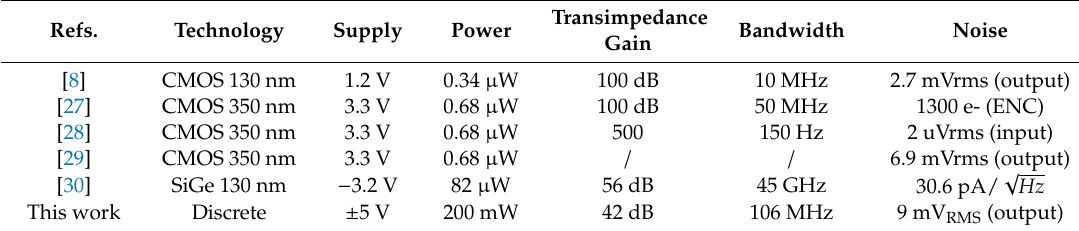
Table 1. Comparison with di ff erent literary